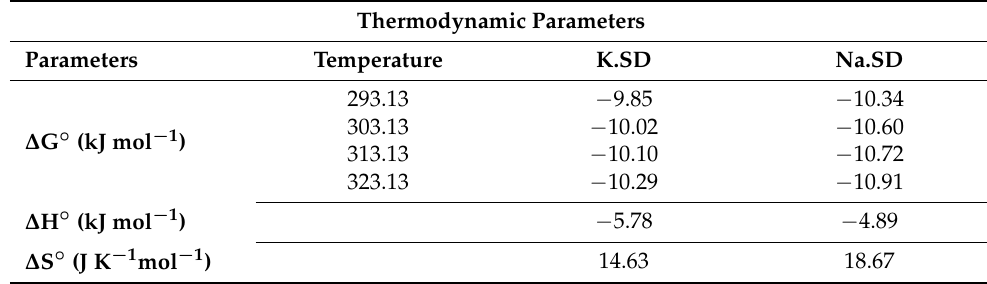
Table 5. The thermodynamic parameters of the phosphate sequestration reactions of K.SD and Na.SD. Thermodynamic